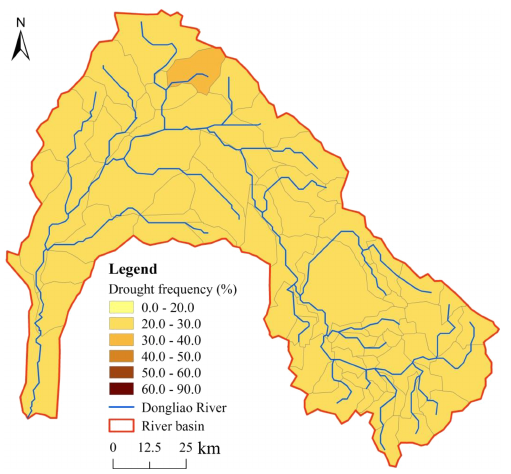
Figure 14. Spatial distribution of drought frequency simulated by the PDSI in the DRB.